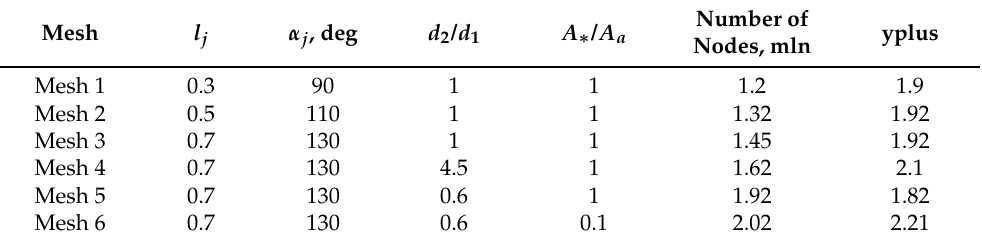
Table 2. Characteristics of different